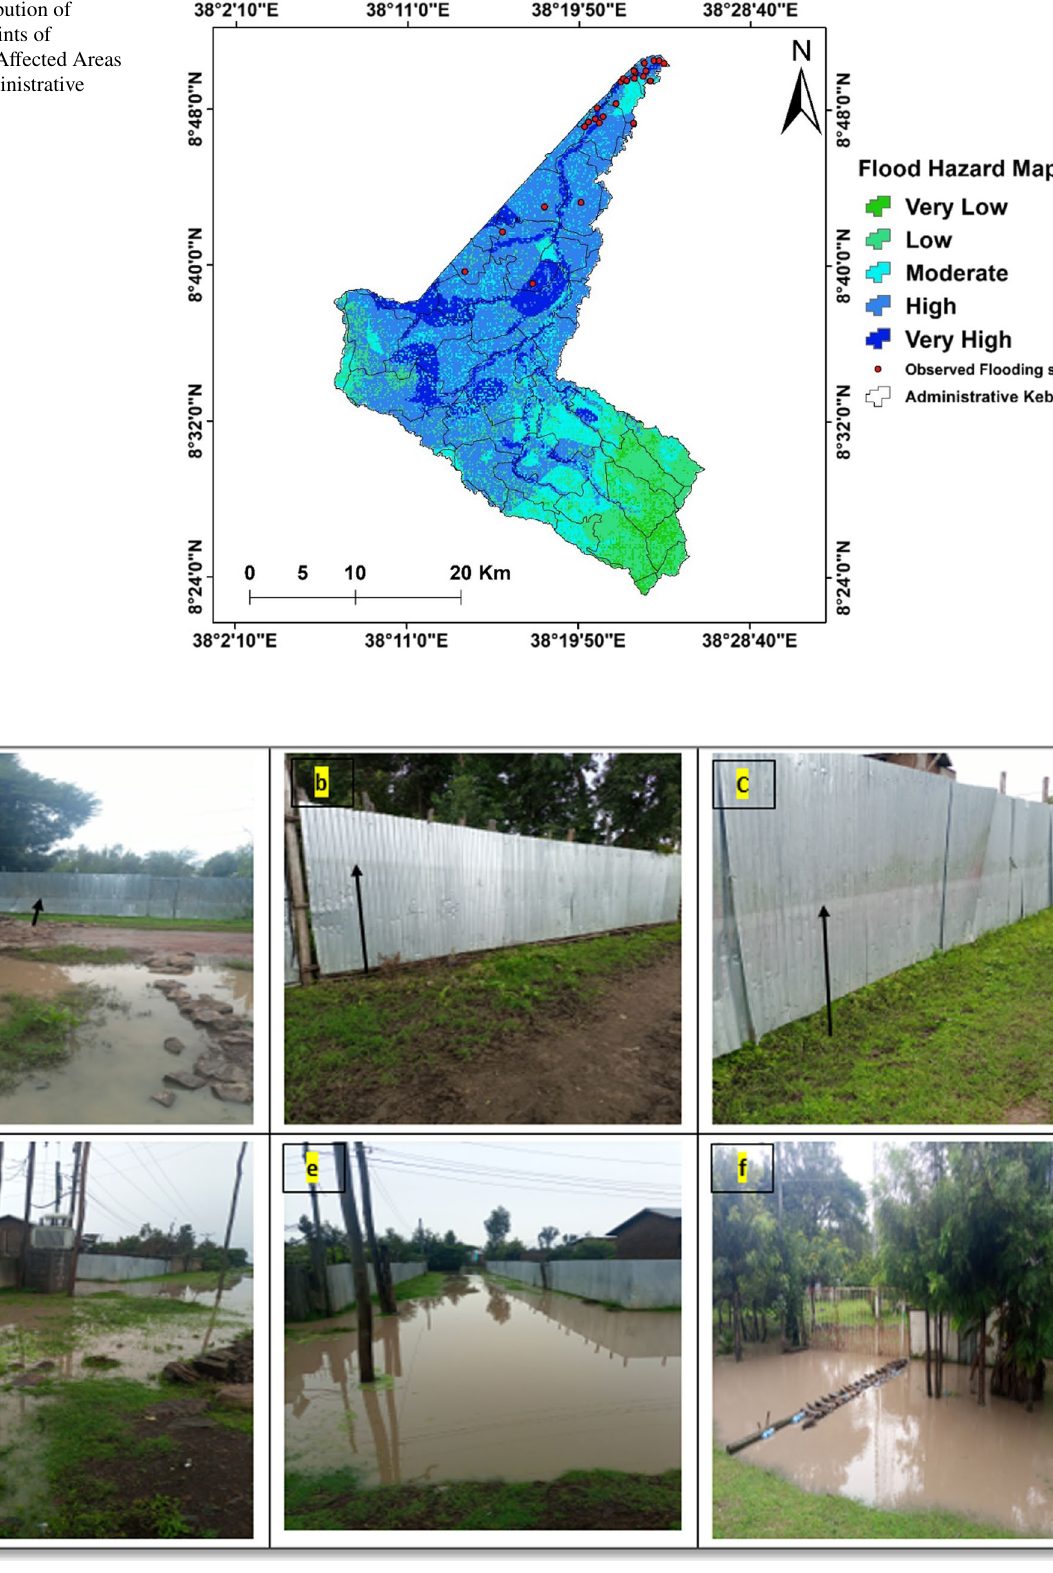
Figure 13 Flood marks of 2019 river flood event in ( a ), ( c ) in Teji and ( b ) in Asgori towns, and ( d , e , f ) flash flood on Teji town around Ilu Police station and Hidasie Telecom